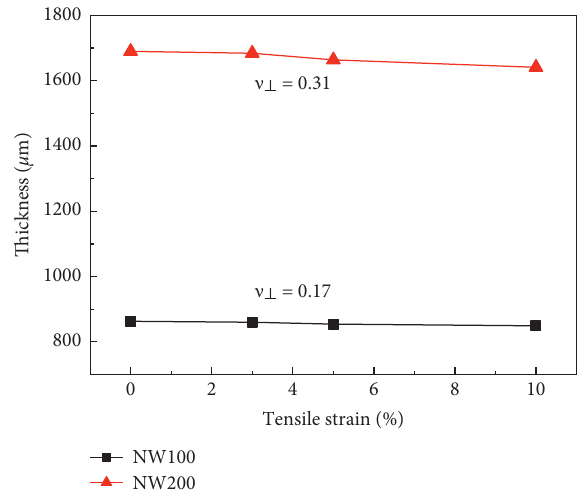
Figure 3: Variations in thickness with tensile strains of NW100 and